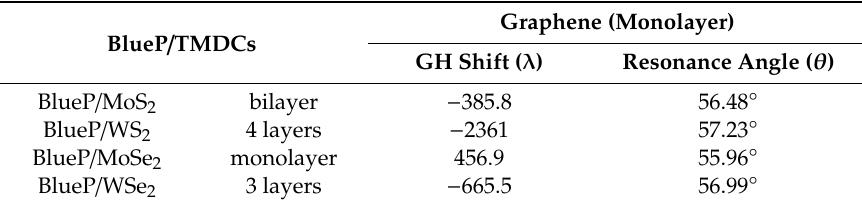
Table 3. The optimal GH shift (S / λ ) and resonance angle ( θ ) with di ff erent number of BlueP / TMDCs and graphene